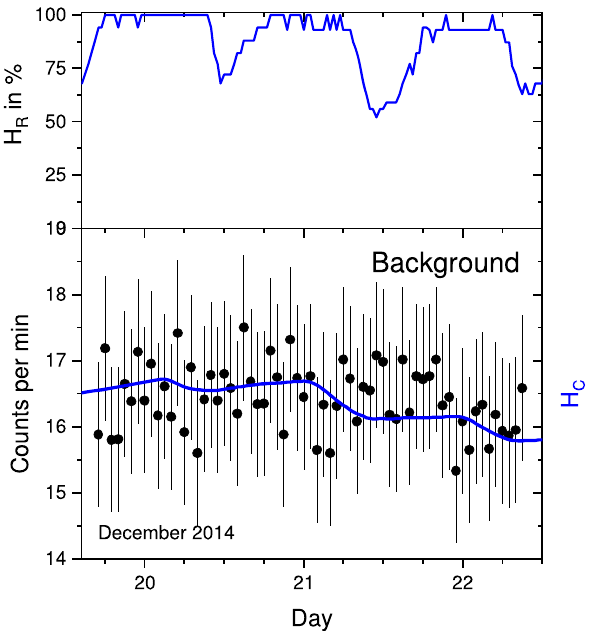
Fig. 7 Relative humidity in the Valencia region (top) in the period 16– 17 Dec 2014 [68]. Qualitative comparison (bottom) of measured 226 Ra decay rates [27,29] with the accumulated-humidity model H C ( t ; ¯ H R = 66% ,(cid:3) t = − 7h ) in Eq. 1. The indicators IN and OUT refer to the position of the detector inside or outside of the MFC